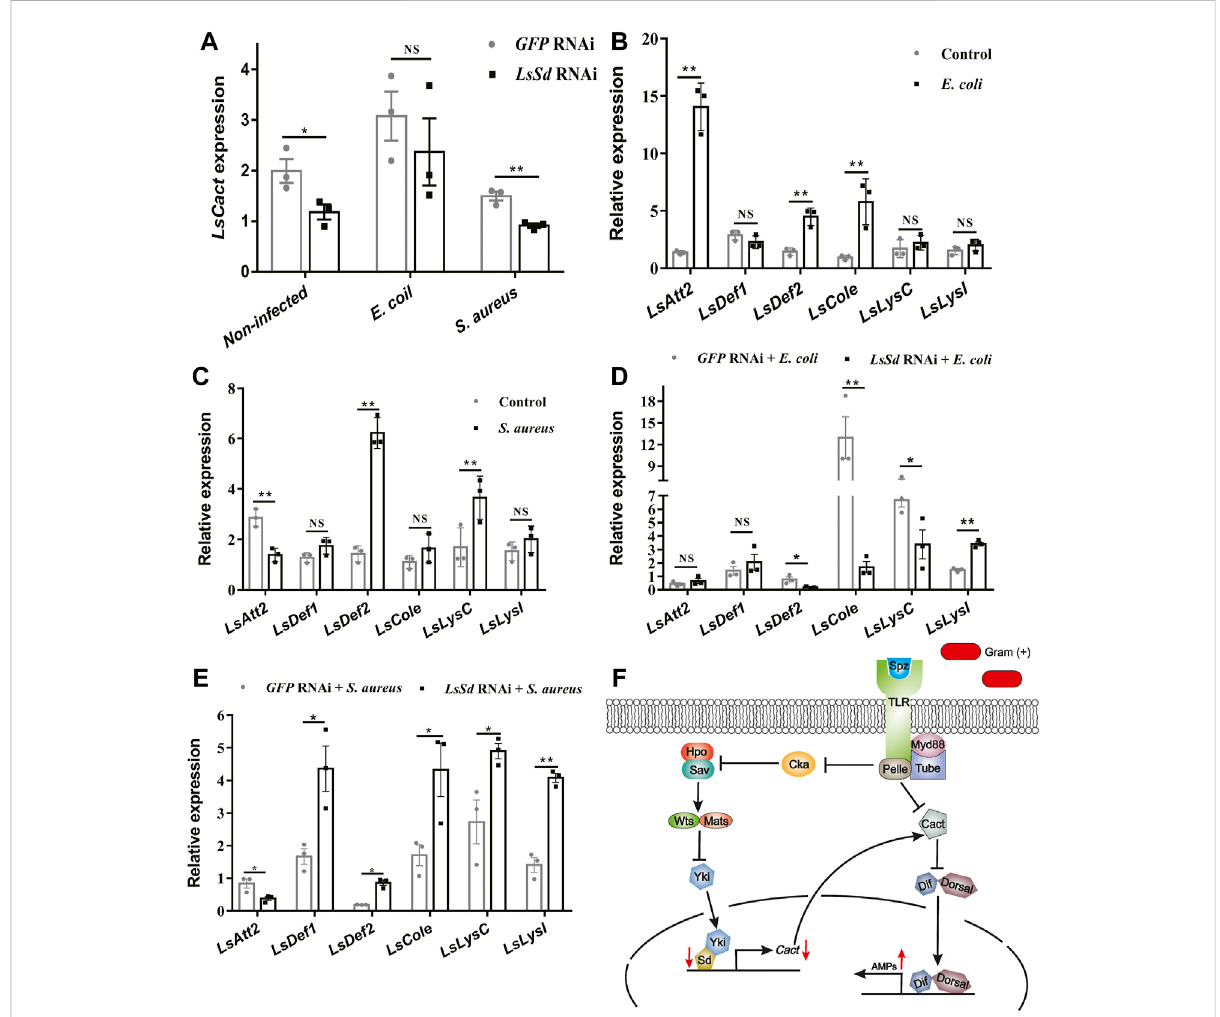
FIGURE 6 LsSd regulatesproductionofanti-microbialpeptidesbyacting LsCact . (A) LsSd -silencedlarvaeweretreatedwithorwithout E.coli and S.aureus stimulations. The mRNA transcript levels of LsCact were analyzed at12 h post-stimulation using RT-qPCR. After challenge injections of (B) E. coli (C) and S.aureus for12 h,themRNAtranscriptlevelsofsixantimicrobialpeptidegeneswereanalyzedbyRT-qPCR. (D) E.coli and (E) S.aureus wereused to stimulate LsSd -silenced larvae. RT-qPCR was used to determine AMPs ’ expression at 12 h post-stimulation. (F) Schematic representation based on previous studies (Liu et al., 2016; Huang et al., 2022) for LsSd -mediated regulation of AMPs in response to the Gram-positive bacteria S. aureus .ErrorbarsindicatetheSEMofthreeindependent biologicalreplications.Asterisksabove barsindicatesigni fi cantdifferences(* p < 0.05;** p < 0.01) analyzed by a Student ’ s t